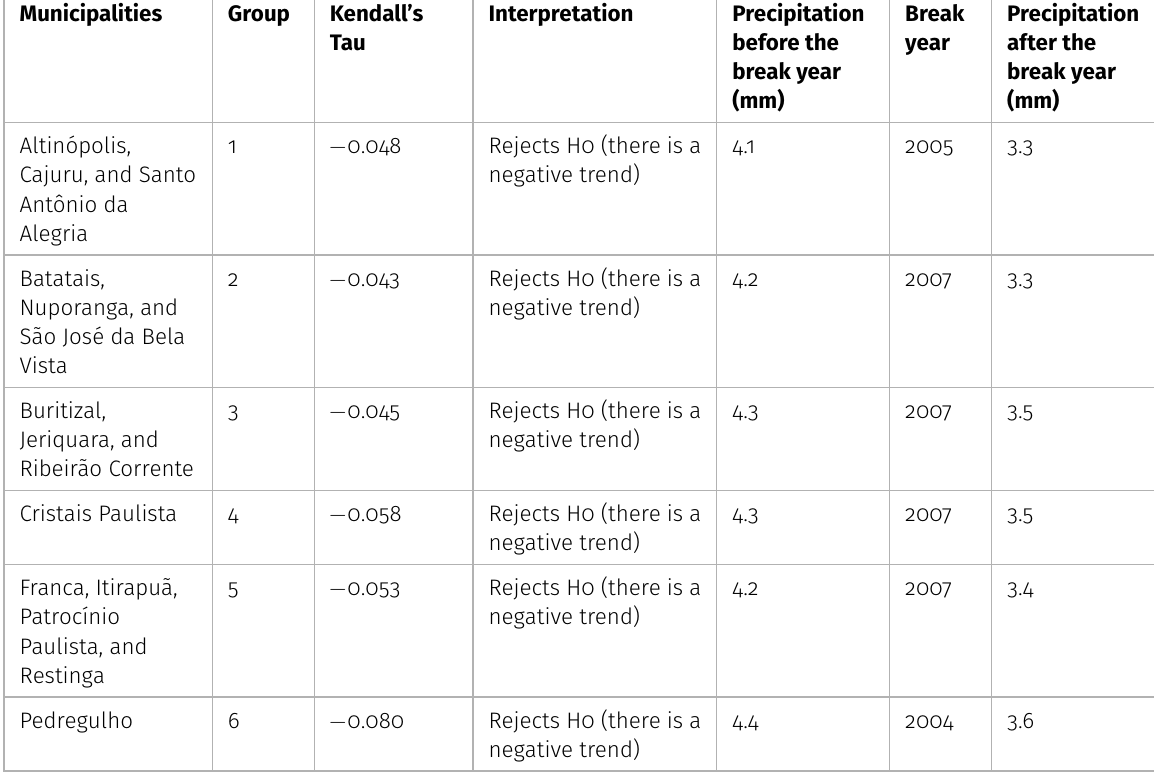
Break Precipitation before the year after the break year break year (mm) (mm) 4.1